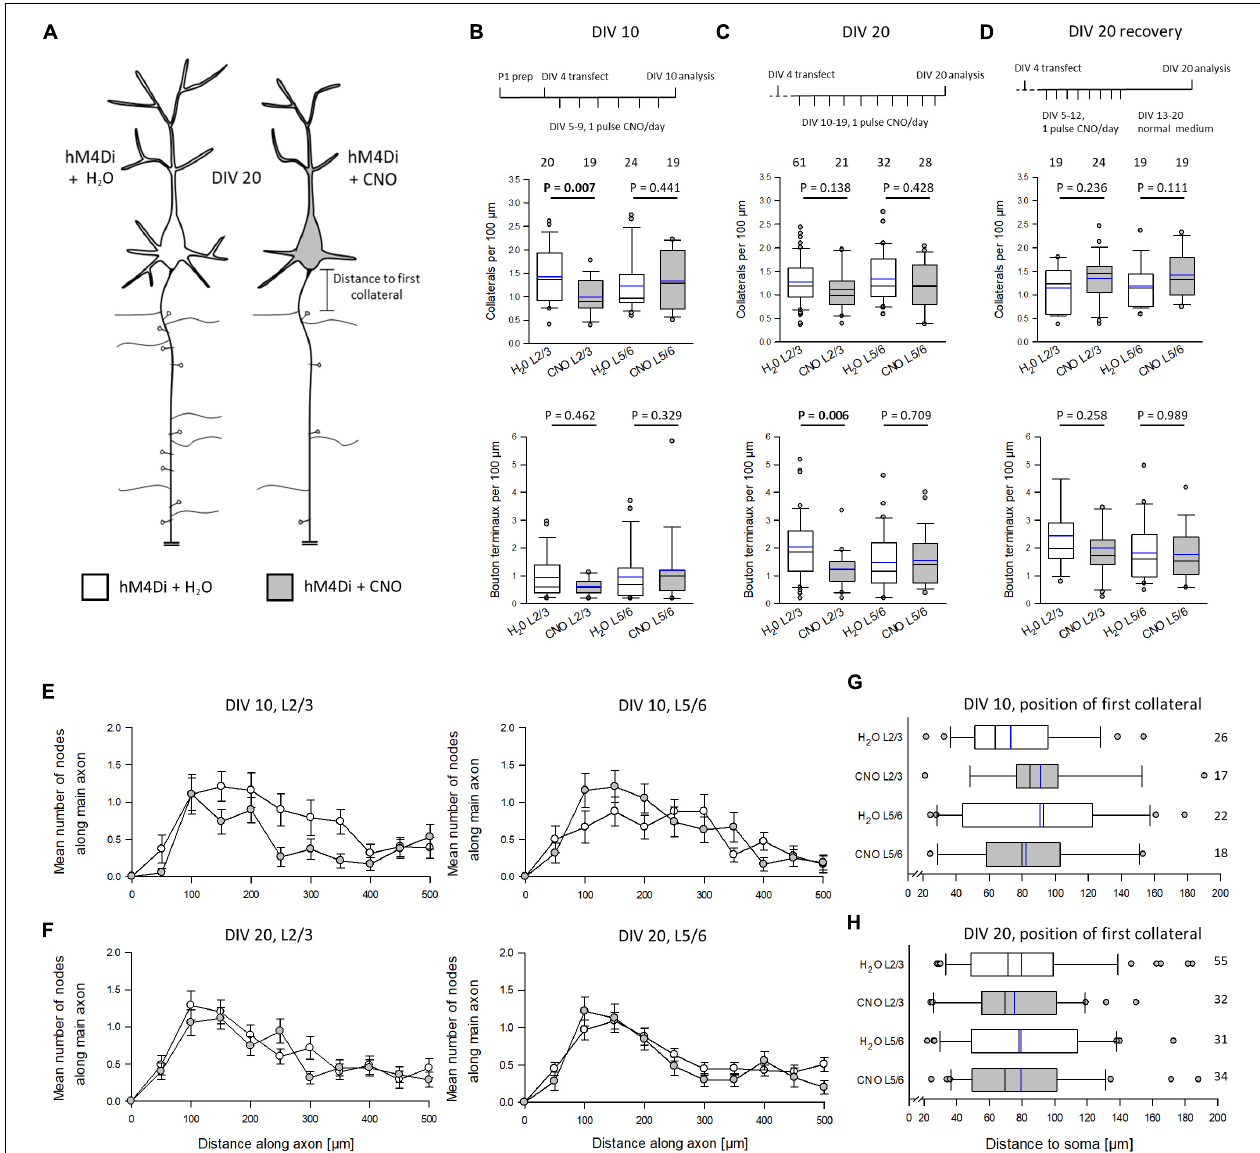
FIGURE 4 | Silencing via hM4Di impairs pyramidal cell axon development. (A) Prolonged activation of hM4Di was hypothesized to impair axonal differentiation. (B) Stimulation protocol, the effect on collateralization, and the effect on the density of bouton terminaux at DIV 10; 3 batches. (C) Stimulation protocol, the effect on collateralization, and the effect on the density of bouton terminaux at DIV 20; 4 batches. (D) Stimulation protocol, the effect on collateralization, and the effect on the density of bouton terminaux at DIV 20 recovery; 3 batches. (E) Distribution of collaterals along the first 500 µ m of the main axon of L2/3 and L5/6 pyramidal cells at DIV 10. (F) Distribution of collaterals along the first 500 µ m of the main axon of L2/3 and L5/6 pyramidal cells at DIV 20. (G) Distance to the soma of the first collateral arising from the main axon of L2/3 and L5/6 pyramidal cells at DIV 10. (H) Distance to the soma of the first collateral arising from the main axon of L2/3 and L5/6 pyramidal cells at DIV 20. Numbers of analyzed neurons in panels (B–F) are given above the boxplots in panels (B–D) , and right of the box plots in panels (G,H) . Black lines in the box plots represent the median and blue lines indicate the mean. Mann-Whitney rank sum test H 2 O control vs. CNO, P -values are